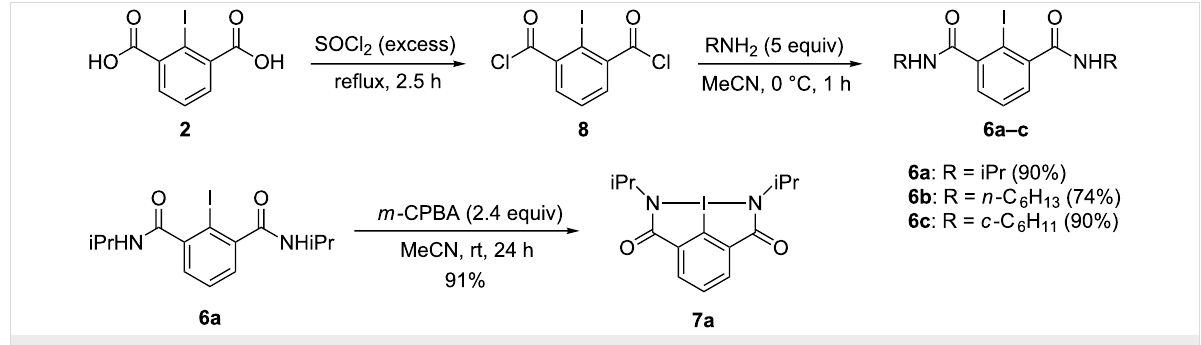
Scheme 2: Preparation of bicyclic benziodazole 7a